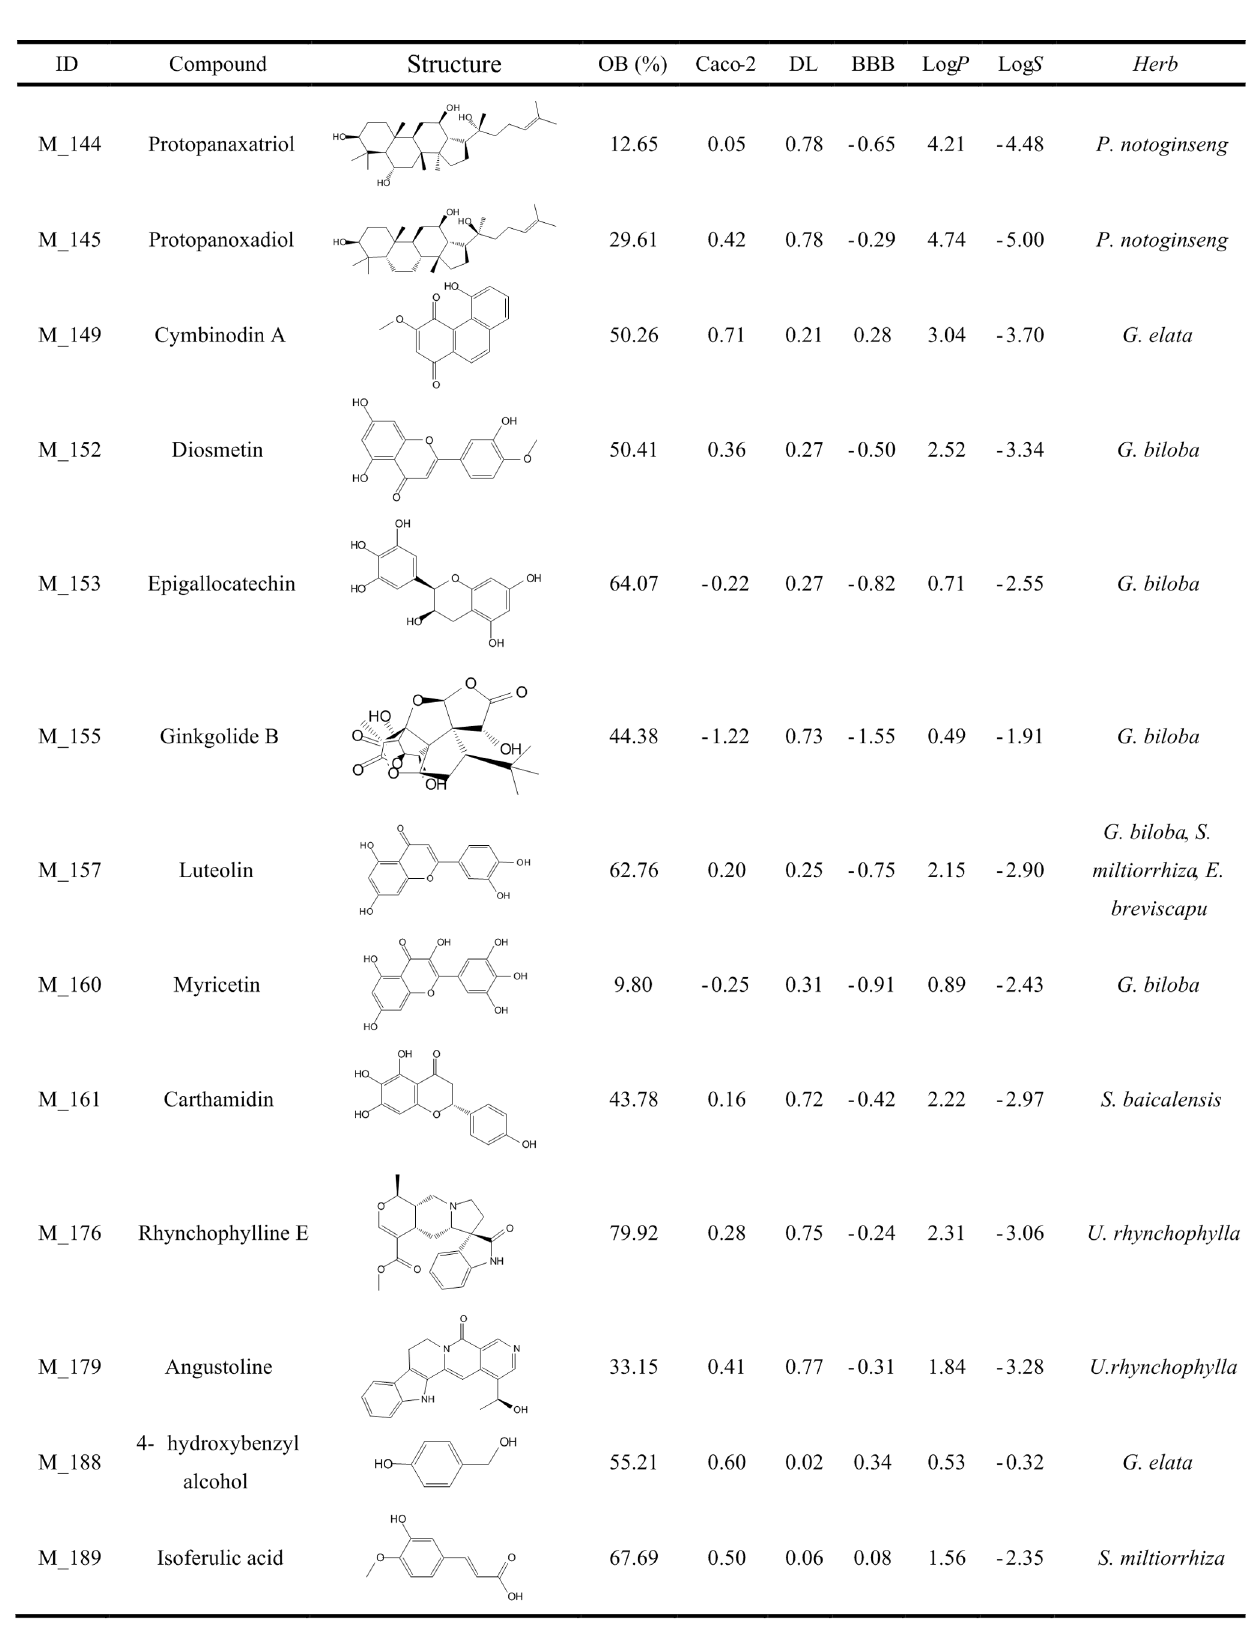
Figure 4. Representative active constituents of anti-stroke herbs and their corresponding ADME parameters (Part 4).